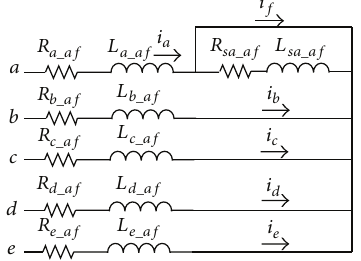
Figure 2: The equivalent circuit of five-phase PMSM with interturn short circuit